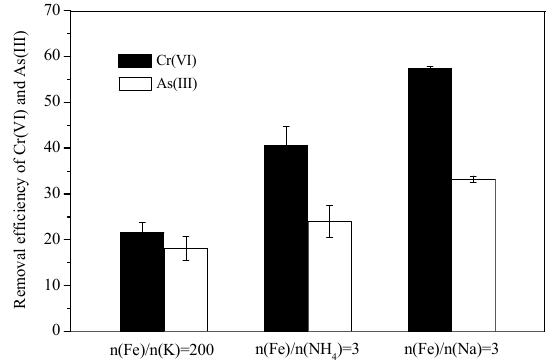
Figure 4. Removal efficiency of Cr(VI) and As(III) in the solution over 0.5 g/L schwertmannite harvested from different biosynthesis systems: n(Fe)/n(K) = 200, n(Fe)/n(NH 4 ) = 3, n(Fe)/n(Na) = 3.